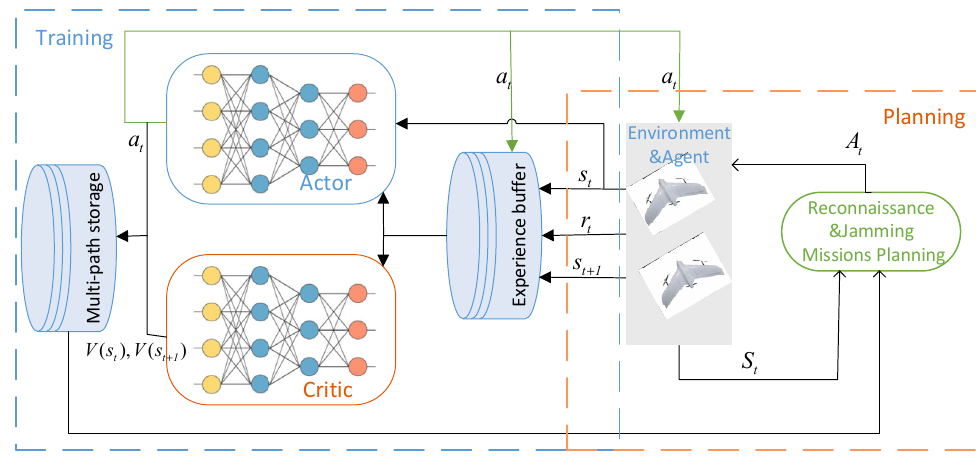
Figure 5. The target reconnaissance mission planning framework.